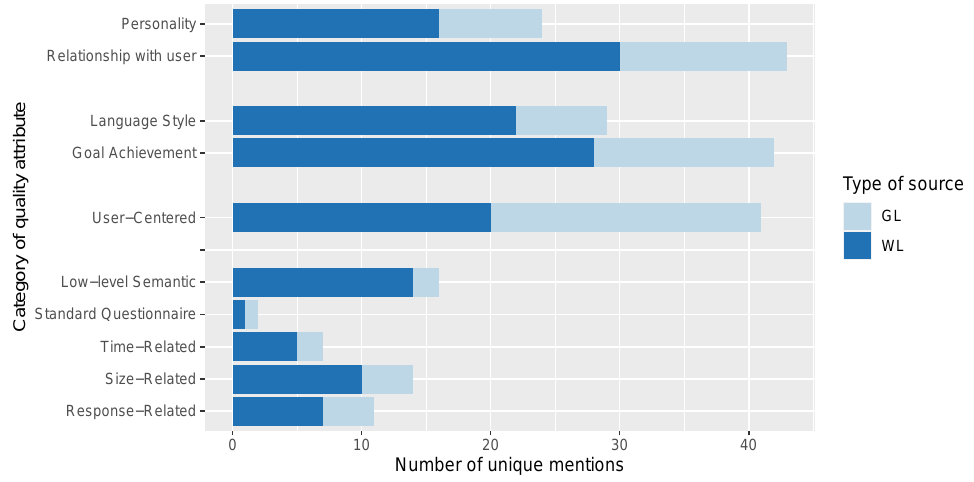
Figure 12. Number of unique mentions per category of quality